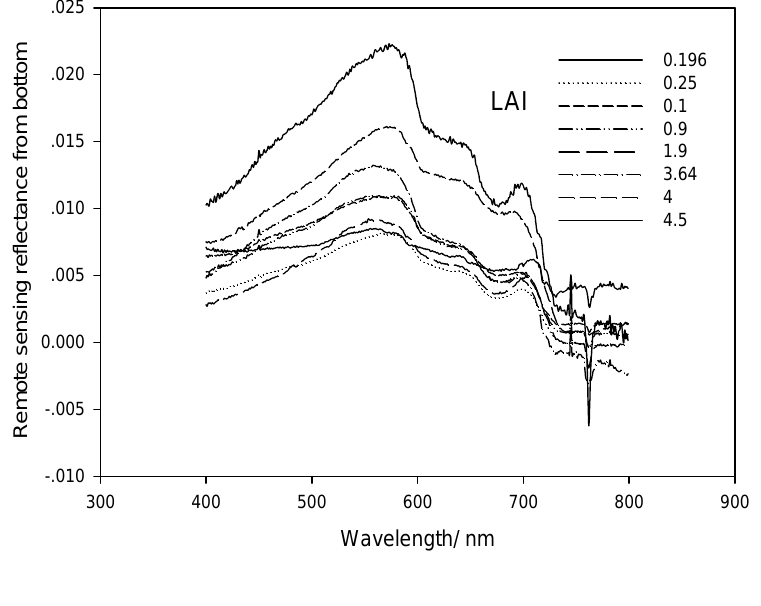
Figure 5. Relationship between LAI and